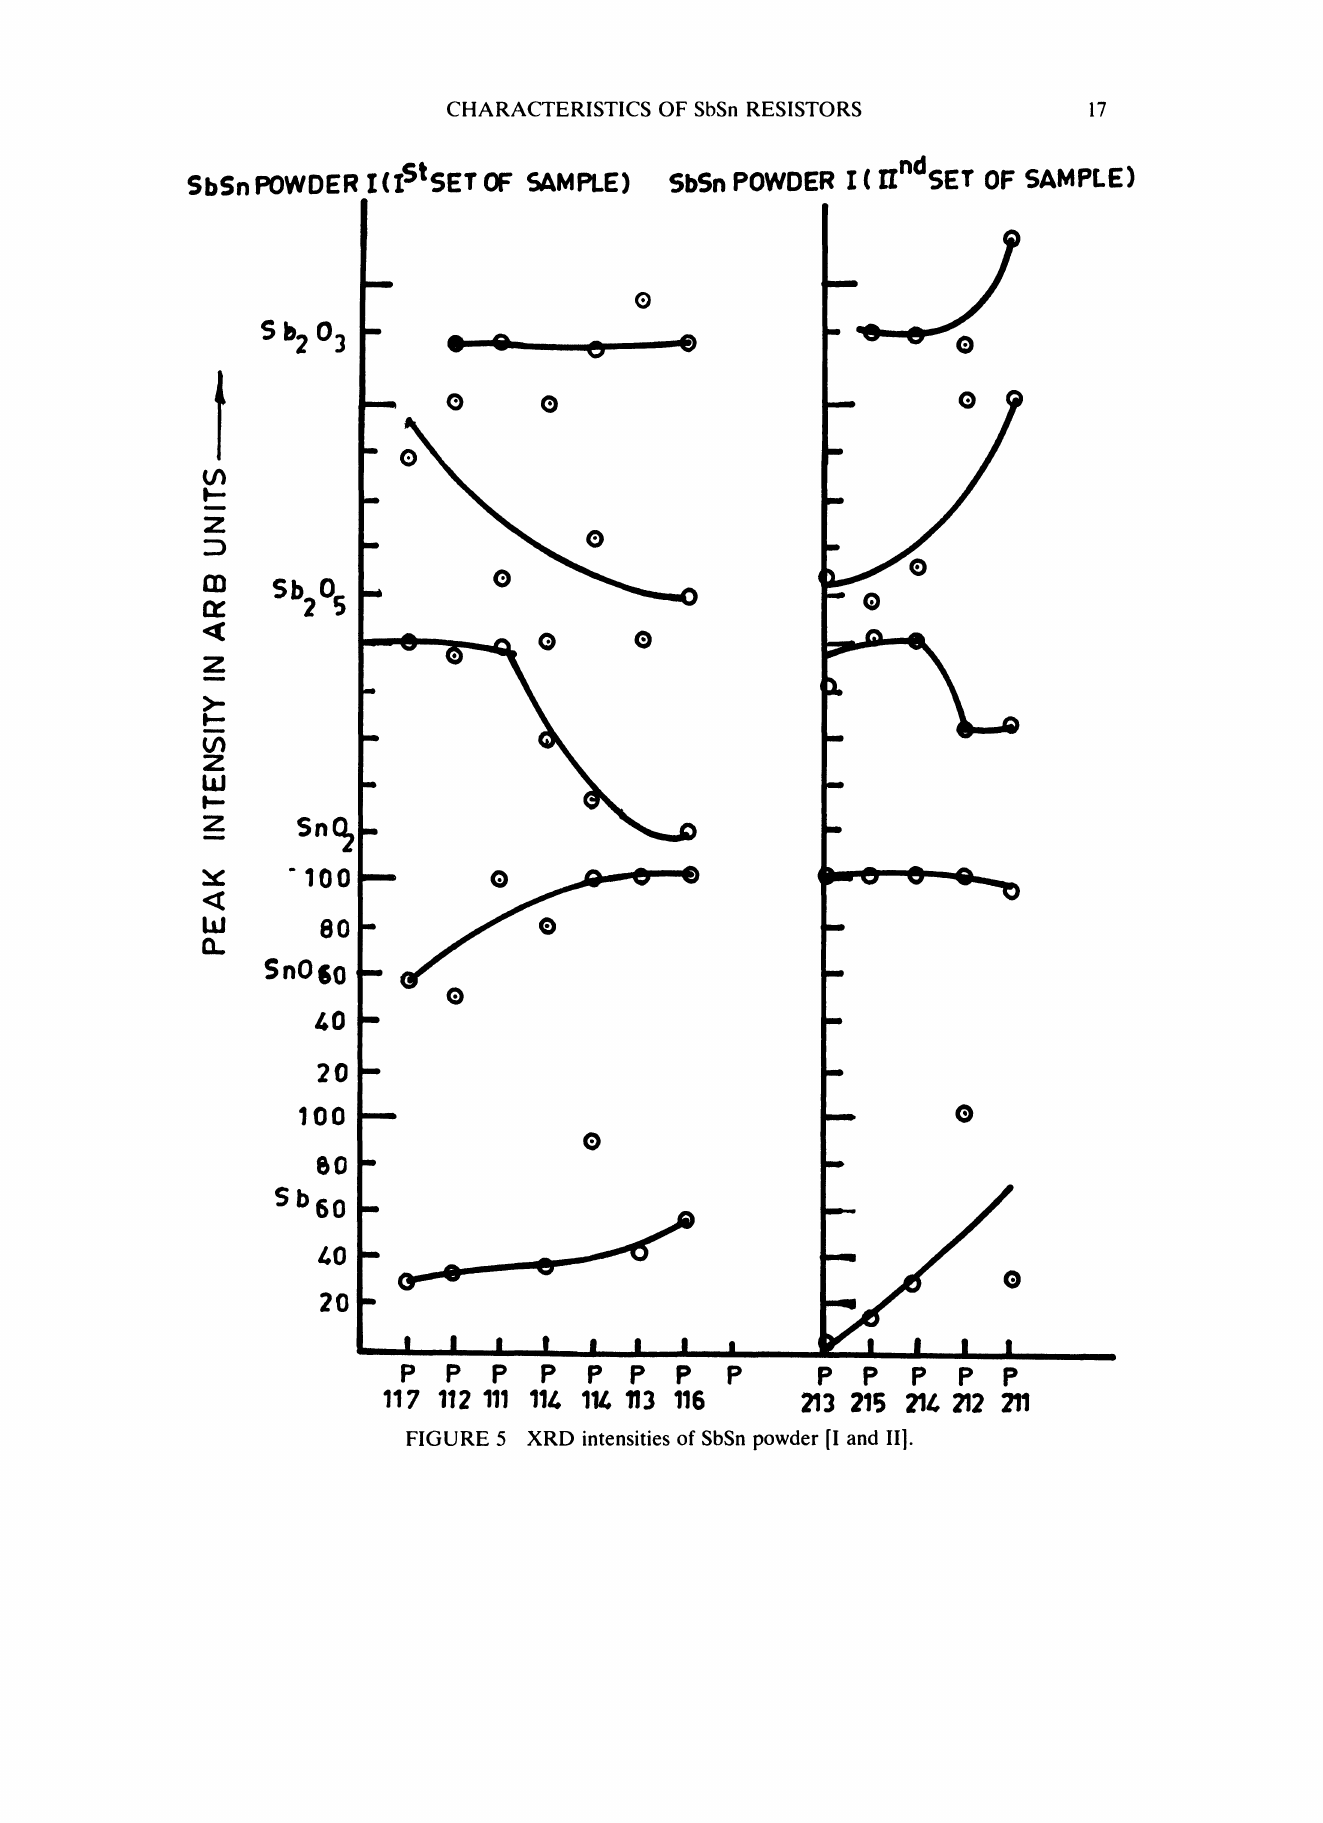
FIGURE 5 XRD intensities of SbSn powder [I and